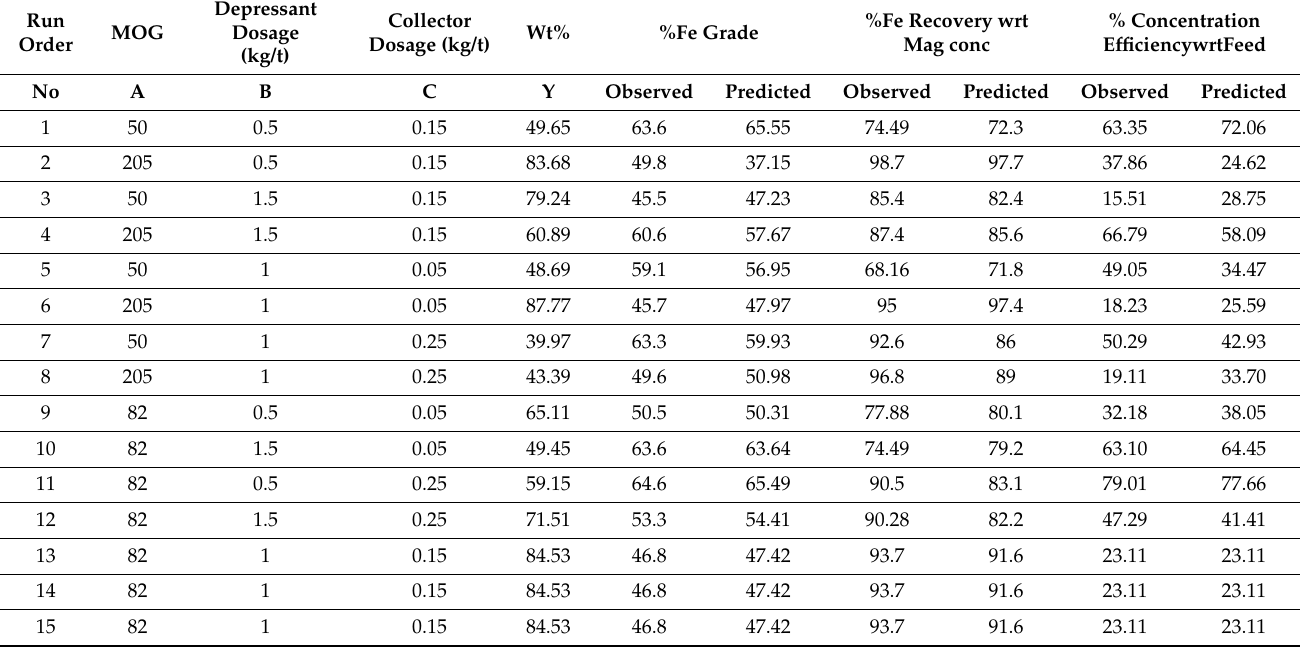
Table 4. The order of experimental test runs conducted and the results obtained.